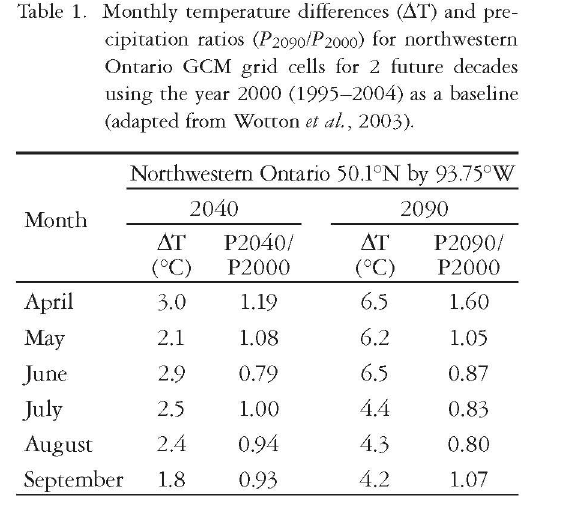
Table 1. Monthly temperature differences (AT) and pre cipitation ratios (P2090/P2000) for northwestern Ontario GCM grid cells for 2 future